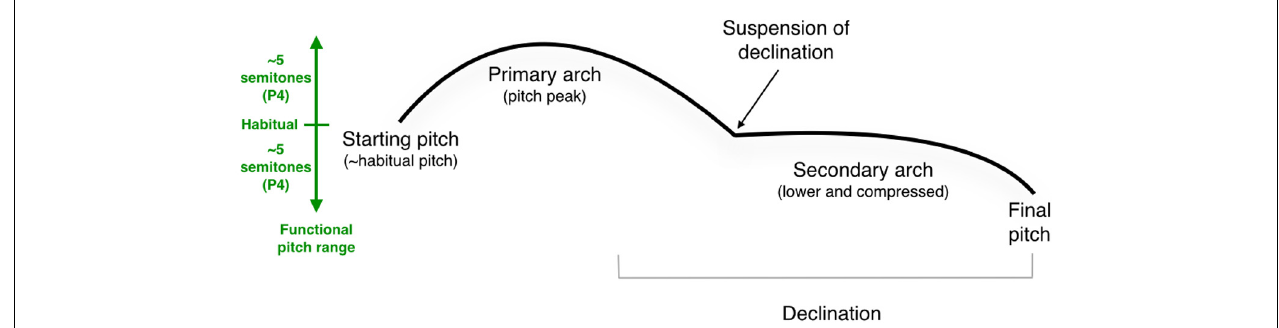
FIGURE 9 | Generic model of the melody of a long declarative sentence. The left side of the figure shows the approximate pitch range for the emotionally neutral intonation of a standard speaker, with the habitual pitch marked in the center, and the functional pitch range mapped out as pitch space above and below the habitual pitch. See text for details about the mechanisms shown. P4, perfect